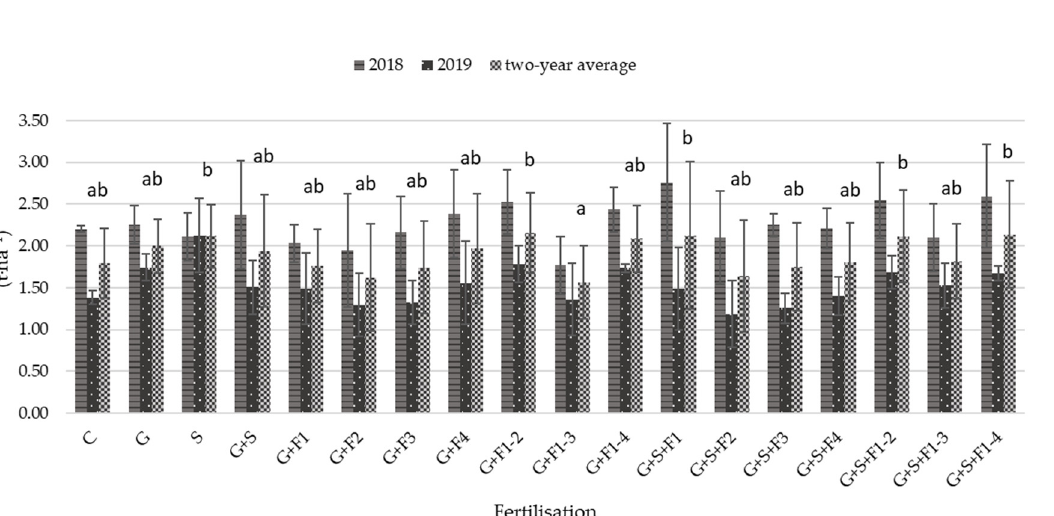
Figure 2. Average grain yield as a function of fertilization (t · ha − 1 ) and homogeneous groups for the average yield of two years. Values are mean ± standard error. a, b, c—Means followed by the same letter are not significantly different from one another based on Tukey’s test at p ≤ 0.05.